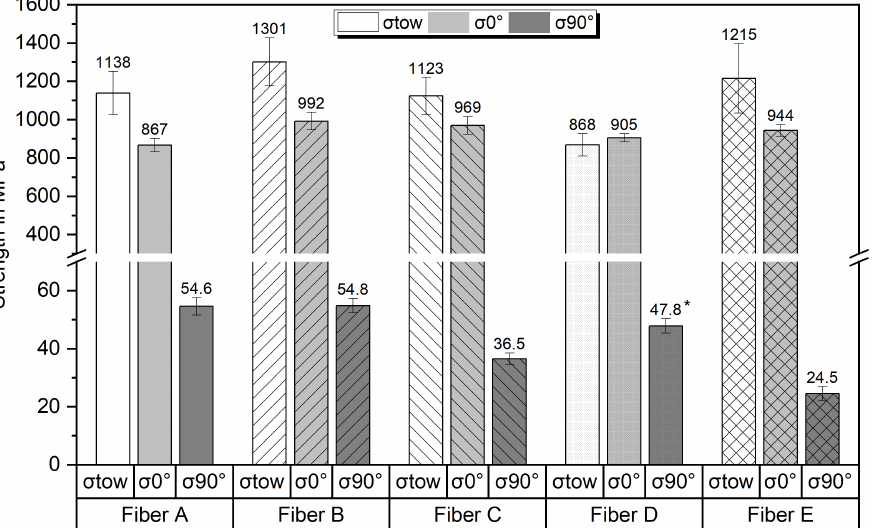
Figure 4. Quasi-static absolute fiber bundle, longitudinal and transverse tensile strength of UD GFRP composites with different NCF input (initial dry reference condition). Shades are corresponding to the NCF input. *: Value according to